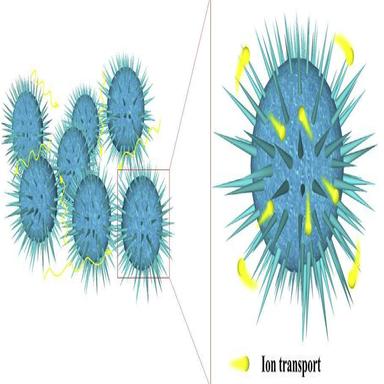
Scheme diagram of ion transport in the PF-NiFe2O4 electrode.